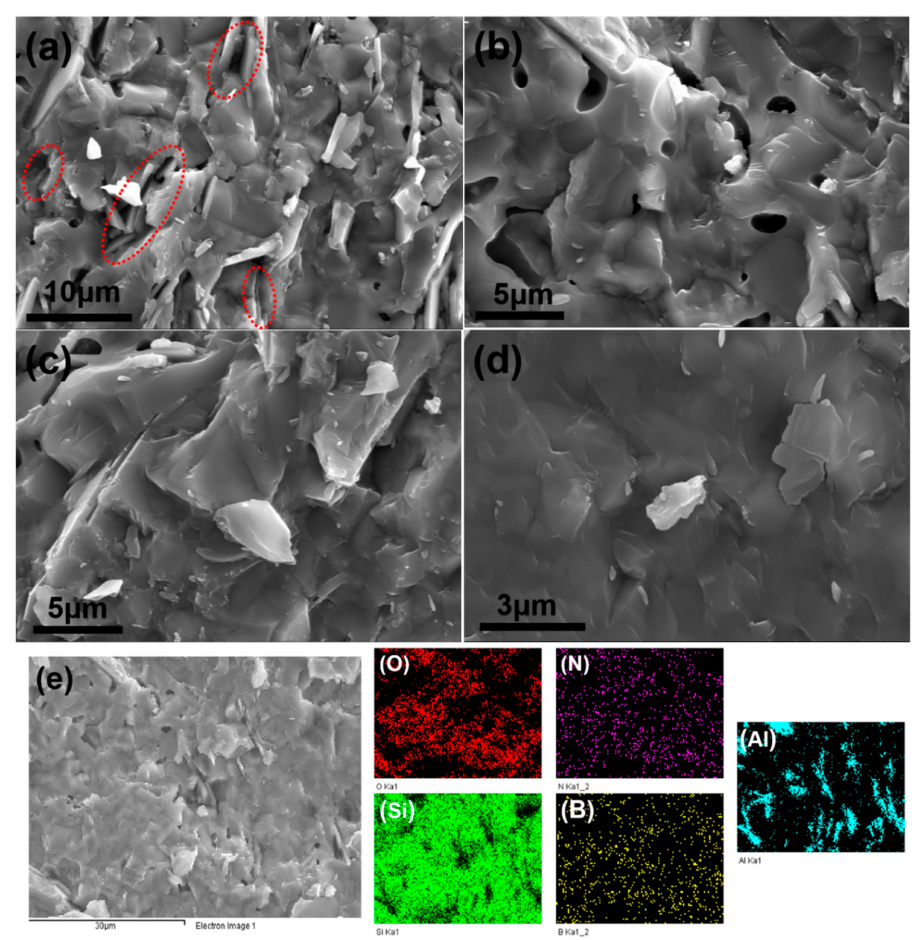
Figure 8. ( a – d ) SEM images and ( e ) EDS mapping of the fracture surface of